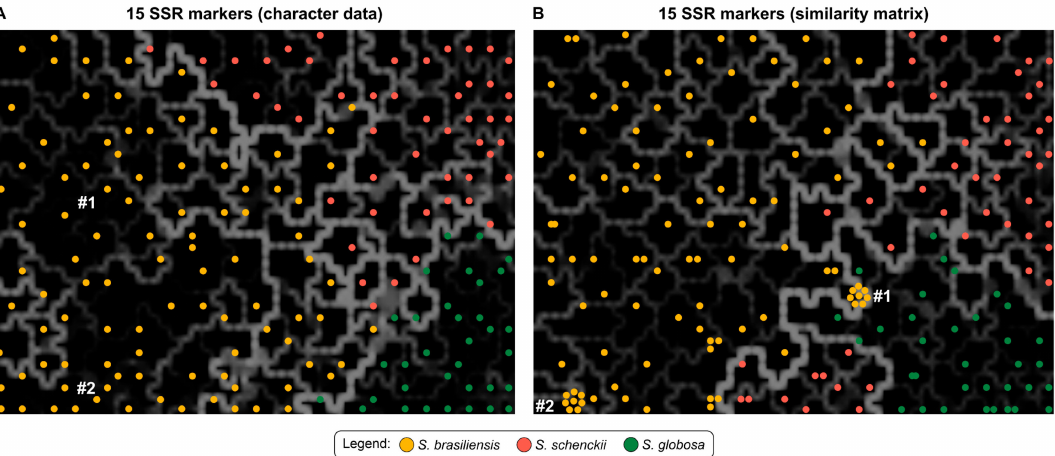
Figure 10. Self-organizing map representing the distribution of 180 Sporothrix isolates genotyped using SSR markers. Kohonen maps using ( A ) character data or ( B ) the similarity matrix. The regions occupied by clonal complexes #1 (Rio de Janeiro and Pernambuco: Ss66, Ss611, Ss612, Ss615, Ss616, Ss1034, Ss1036, and Ss1037) and #2 (S ã o Paulo: Ss631, Ss653, Ss663, Ss669, Ss676, Ss681, Ss683, and Ss684) are indicated. The dimensioning analyses were performed using BioNumerics v7.6 to determine the consistency of the differentiation of the populations defined by the cluster